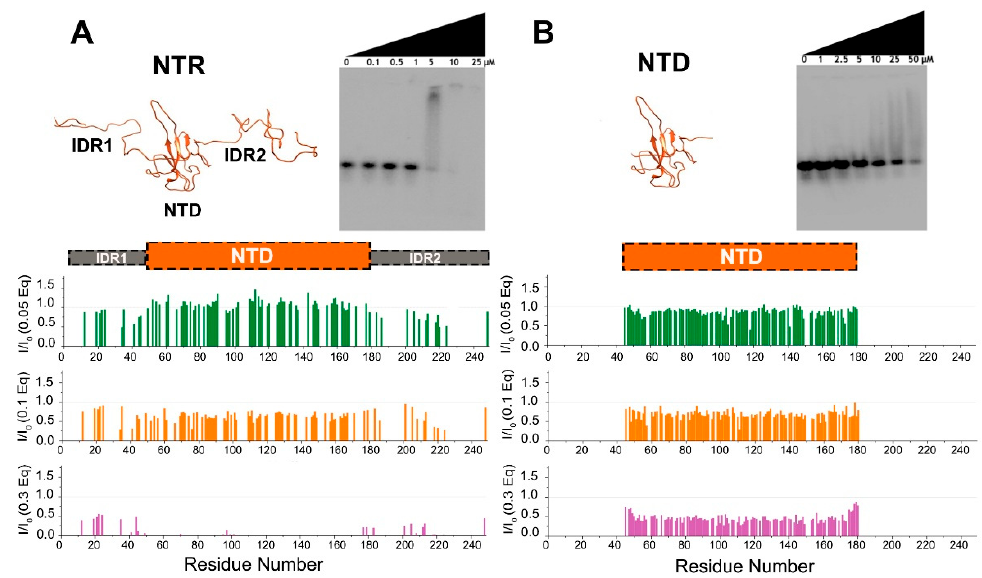
Figure 2. Differences in the interaction of NTR ( A ) and NTD ( B ) with 5_SL4 followed by NMR and EMSA. Upper panels show the two constructs and their different binding affinities for RNA as demonstrated by EMSA experiments. The binding of NTR to RNA occurs at a lower concentration as compared to that of NTD alone. The lower panels show plots of the HN HSQC peak intensity ratios versus residue number after the addition of increasing amounts of 5_SL4 (with equivalents as indicated) relative to protein. The structural models were obtained as described in the experimental part.